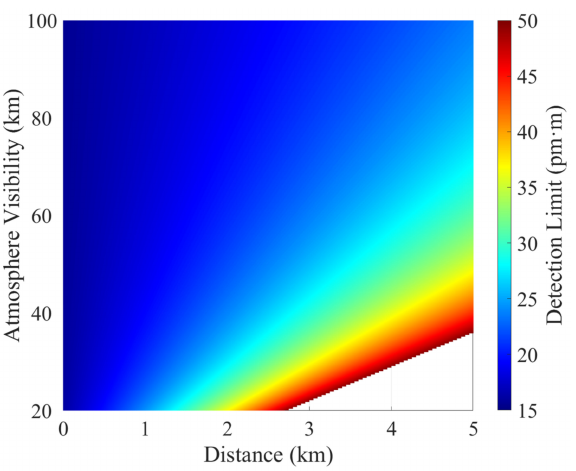
Figure 6. The simulated detection limit of SO 2 cameras at different monitoring distances and atmospheric